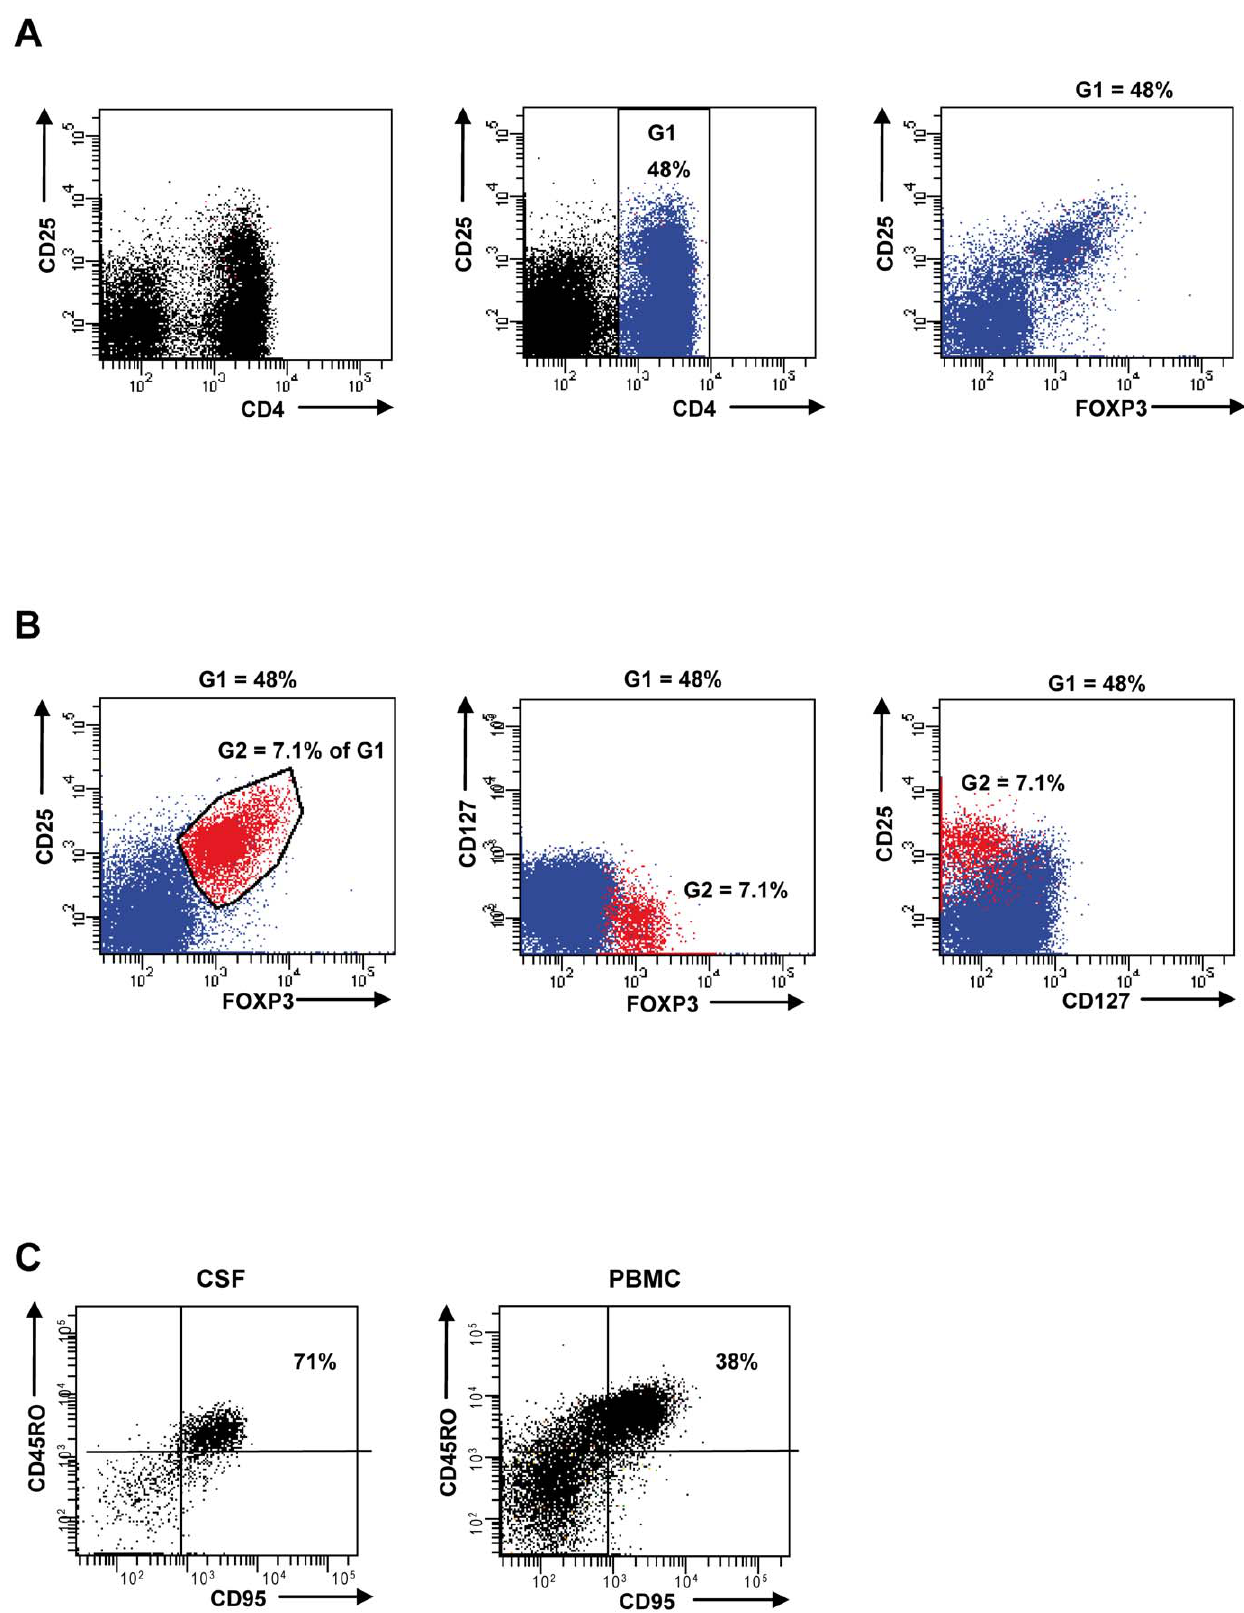
Figure 2. Representative six-color FACS analysis of lymphocytes derived from CSF and peripheral blood. Isolated lymphocytes were stained with monoclonal antibodies against CD4, CD25, CD127, FOXP3, CD45RO and CD95. CD4 + cells were gated (G1) and analyzed for FOXP3, CD127 and CD25 (A) . CD4 + cells are shown in all other dot plots of Fig. 2A, B in blue and represent 48% of peripheral lymphocytes. (B) CD4 positive